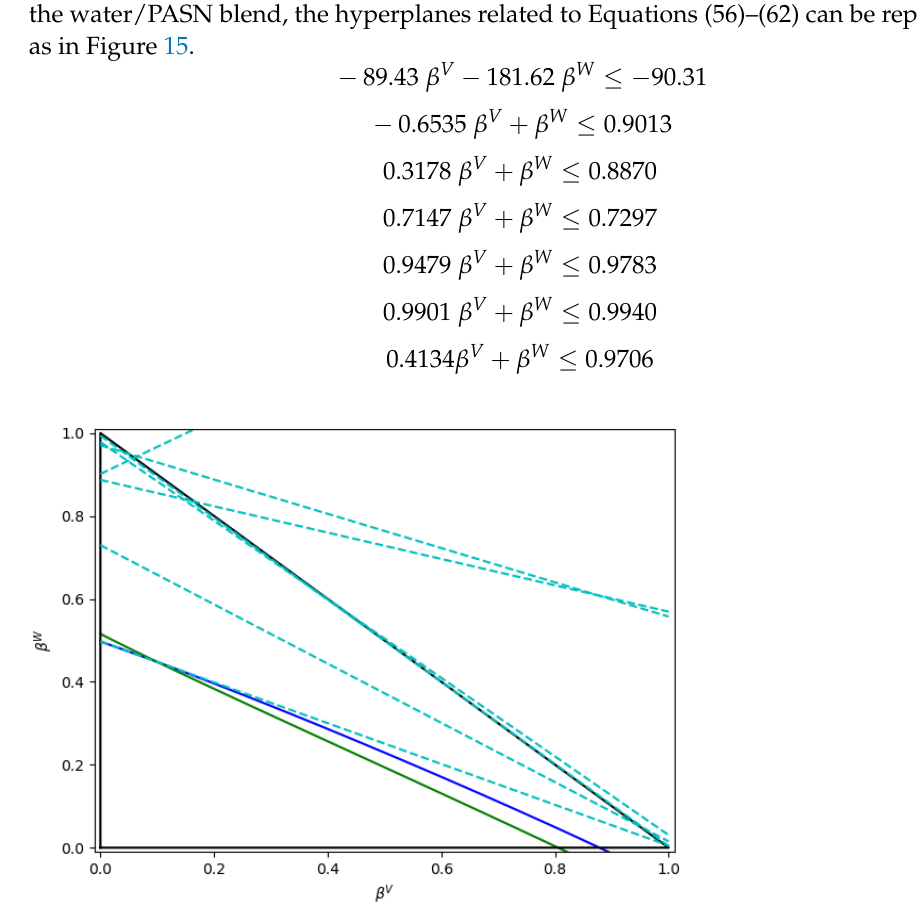
Figure 15. Boundaries for β V and β W as poposed by Okuno et al. [20] for water/PASN mixtures. Notes: (i) the blue solid lines are related to RR w = 0, (ii) the green solid lines to RR y = 0, and (iii) the cyan broken lines represent the boundaries according to Equations (56) – (62).